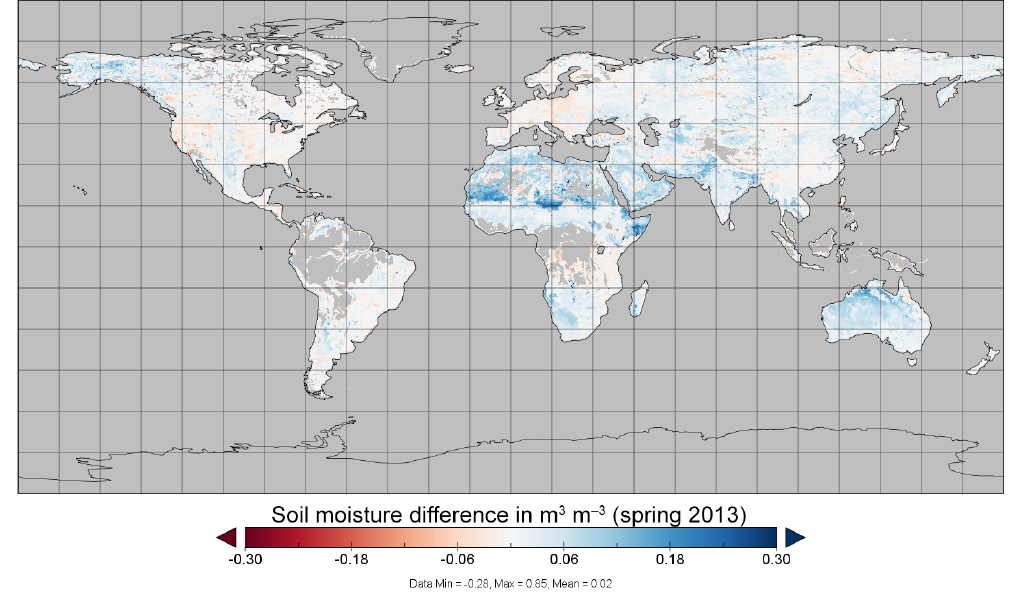
Figure B3. Absolute differences in soil moisture (ESA CCI SM minus CCI NRT) for spring 2013.